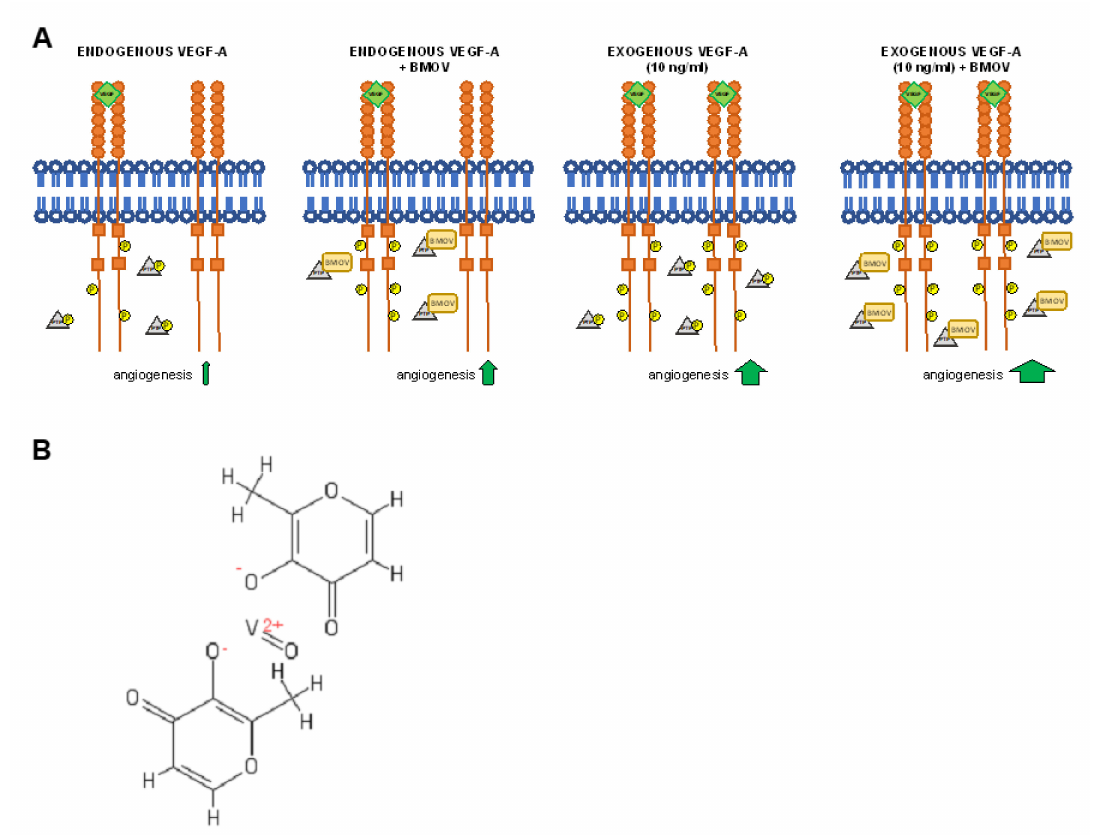
Figure 1. ( A ) Schematic representation of VEGFR2 signaling activation in response to the indicated conditions. ( B ) bis(maltolato)oxovanadium(IV) (BMOV) chemical structure.